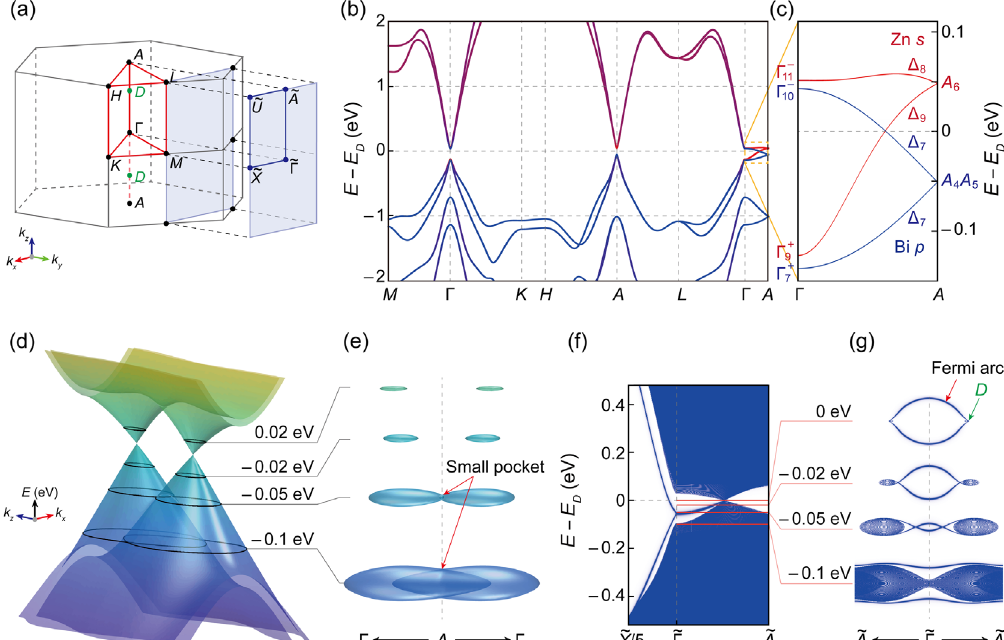
FIG. 2. Calculated band structure of KZnBi. (a) Bulk and (010) projected surface BZ of KZnBi with high symmetric points. Two Dirac points (green dots, labeled “ D ” ) exist along the Γ - A line. (b),(c) Calculated band structure of KZnBi along the high symmetry lines (b) and the expanded band structure along Γ - A (c). The red and blue represent the Zn s and Bi p orbitals, respectively. (d) Dirac bands on the k - k plane. (e) Anisotropic isoenergy surfaces of Dirac bands along the k x z below − 50 meV. (f) Calculated surface state for (010) plane. (g) Isoenergy surfaces of the surface band structure with Dirac points and Fermi